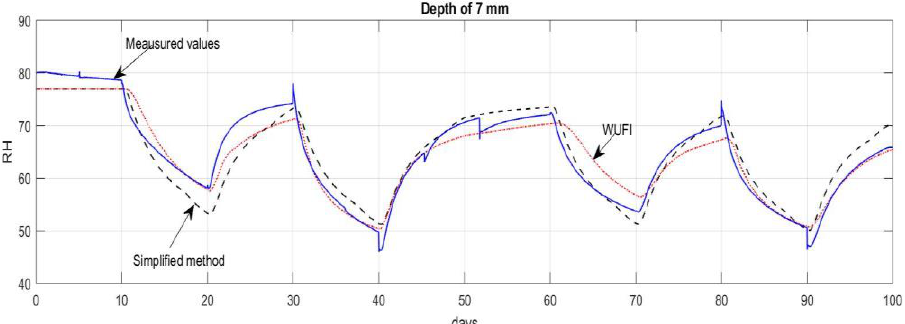
Figure 3. The results at 7 mm depth of the calculated RH in comparison with the measured data. The blue solid line indicates the measured data, the black dotted line is the simulation by WUFI ® Pro and the red dashed line the Simplified model .